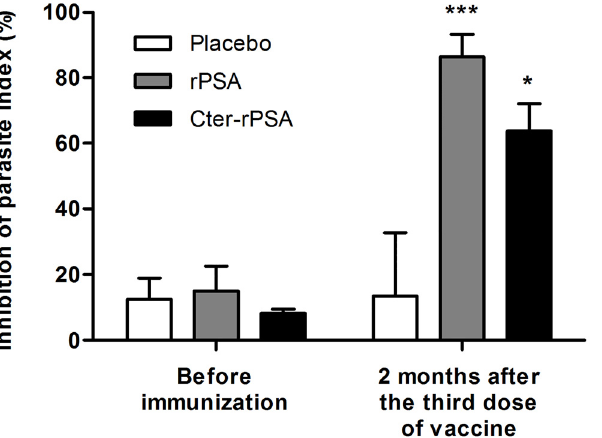
Fig 4. Anti-leishmanial activity of canine monocyte-derived macrophages in non-immune and immune dogs. The ability of pre-infected canine monocyte-derived macrophages to kill Leishmania parasites when they were exposed to autologous peripheral lymphocytes derived from PBMC was expressed as the percentage of parasitic index inhibition after in vitro infection with Leishmania infantum promastigotes (MHOM/MA/67/ITMAP-263) and 72 h incubation with and without autologous lymphocytes. Anti-leishmanial activity of co-cultured canine macrophages was evaluated immediately before immunization and two months after the third dose. Values represent means +/- standard deviation of duplicate experiments ( * p < 0.05, ** p < 0.01, *** p <